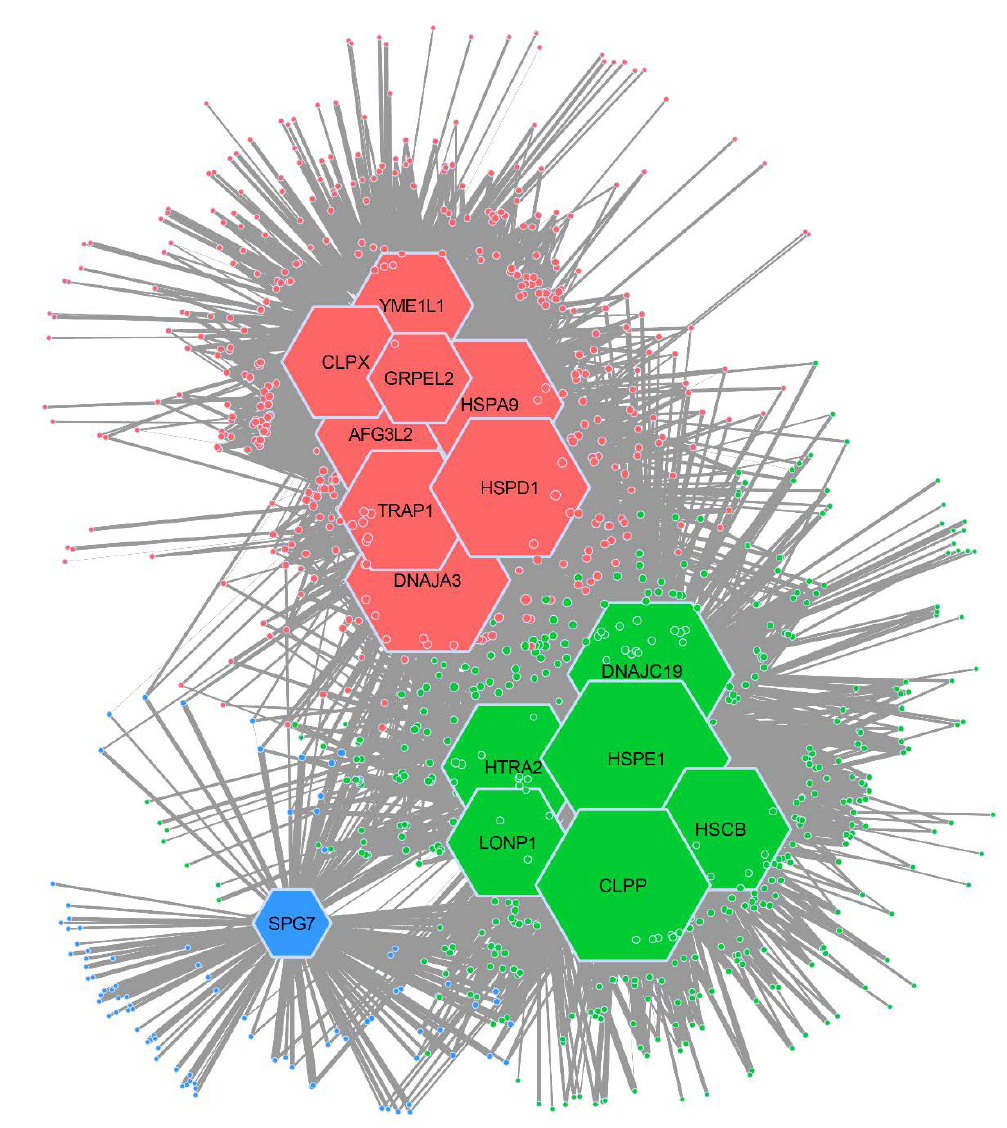
Figure 2. Network analysis of mitochondrial chaperone–client co-expression. An Infomap tool was used to analyze the structure of the mitochondrial chaperone–client co-expression network, revealing three distinct modules. Module HSPD1 is depicted in red; module HSPE1 is depicted in green; and module SPG7 is depicted in blue. Size of the chaperone reflects the number of interactions. Modules are named after the chaperone with most interactions.